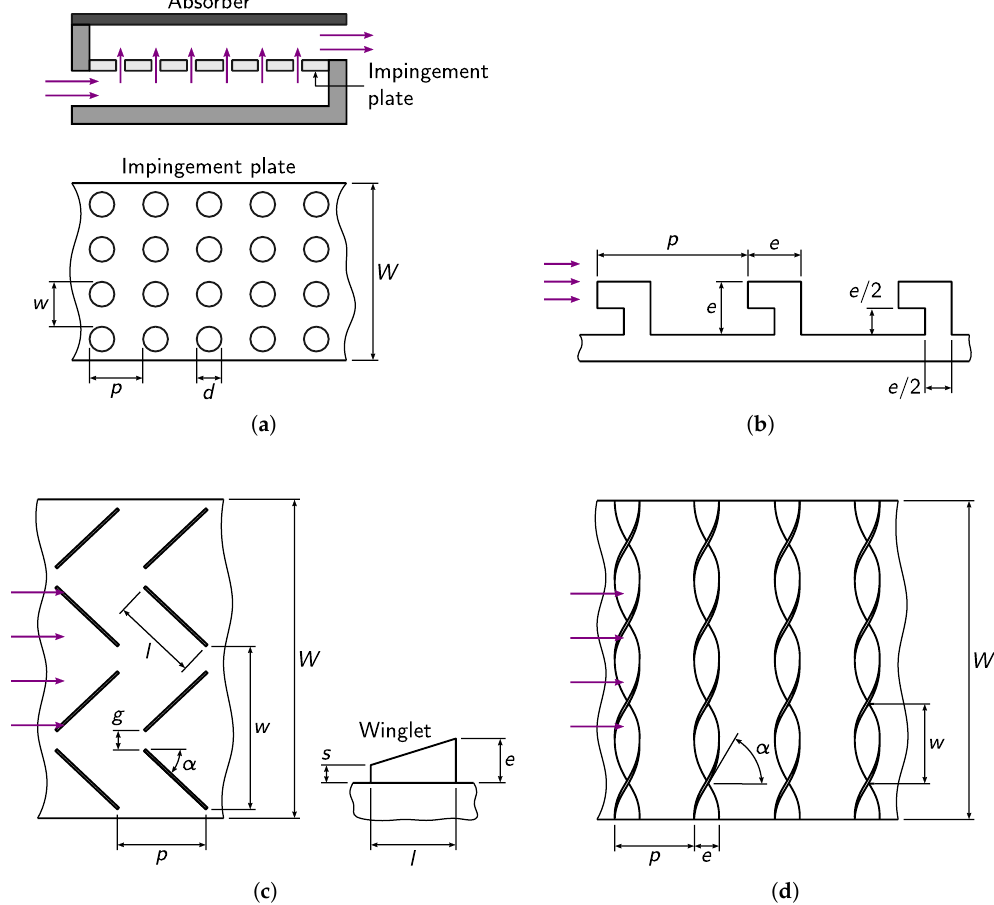
Figure 17. Rib arrangement and roughness parameters of absorber plates with other obstacle types.